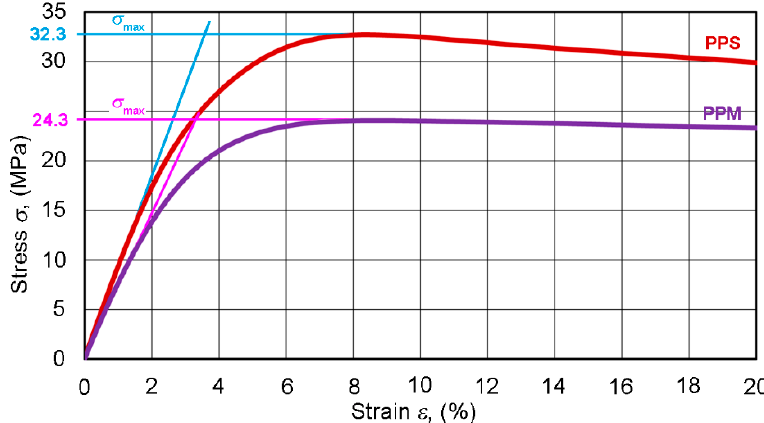
Figure 8. An enlarged view of the initial section of tensile stress—strain curves of typical PPS and PPM specimens. The inclined straight lines are secants at a 0.3–1.5% elongation, but the horizontal straight lines determine the value of σ max . Table 4. Results of tensile tests on PPS and PPM specimens, with standard deviations in absolute values.